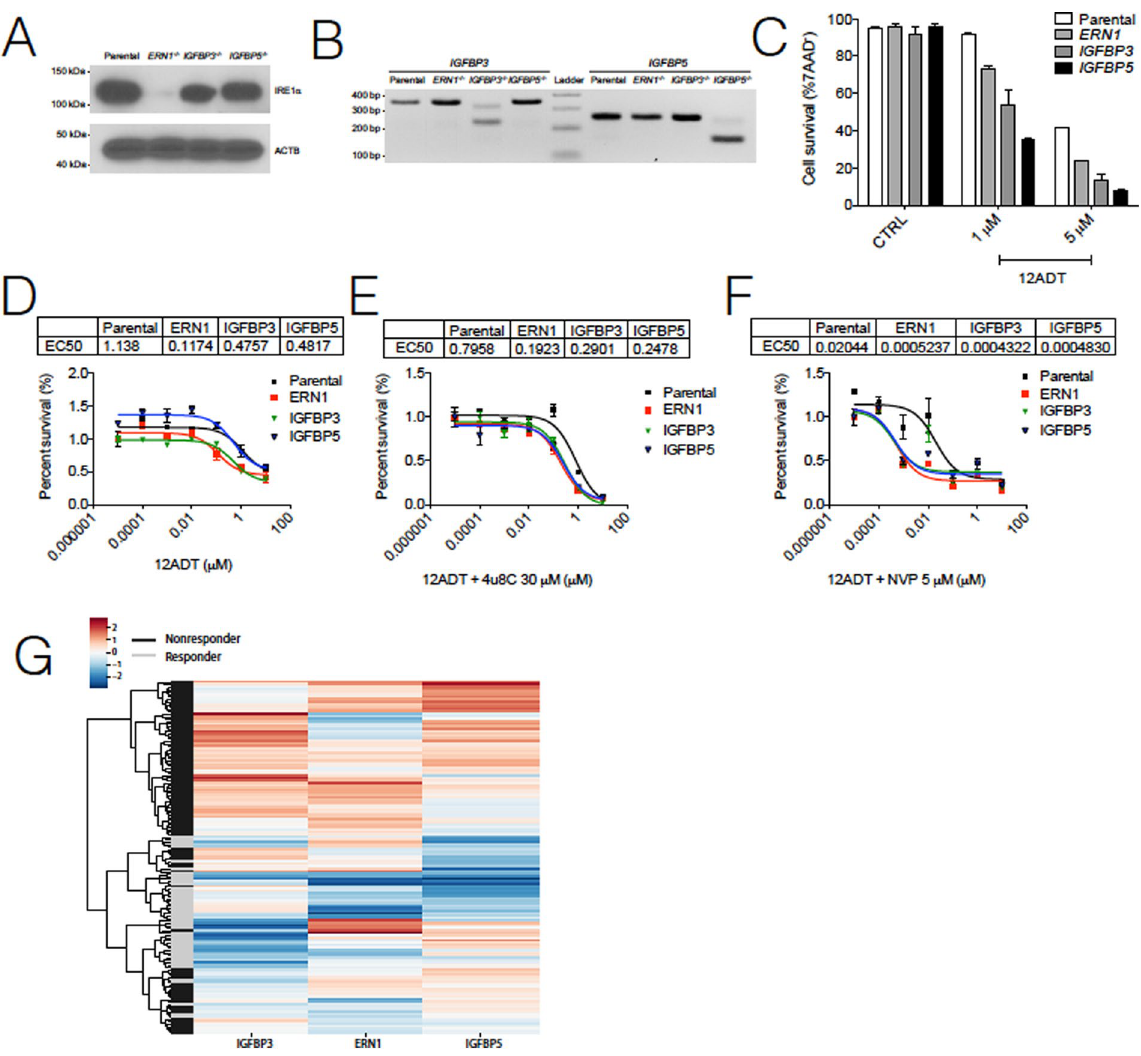
Figure 4. Loss of ERN1, IGFBP3, IGFBP5 sensitize cells to 12ADT toxicity. ( A ) Western blot detection of IRE1 in U251 parental and CRISPR deleted ERN1, IGFBP3, IGFBP5 . ( B ) PCR detection of IGFBP3 and IGFBP5 of U251 parental and CRISPR deleted ERN1, IGFBP3, IGFBP5 . ( C ) Percent survival of U251 parental (WT) or CRISPR U251 cells during increasing concentrations of 12ADT after 48 hours. Survival determined